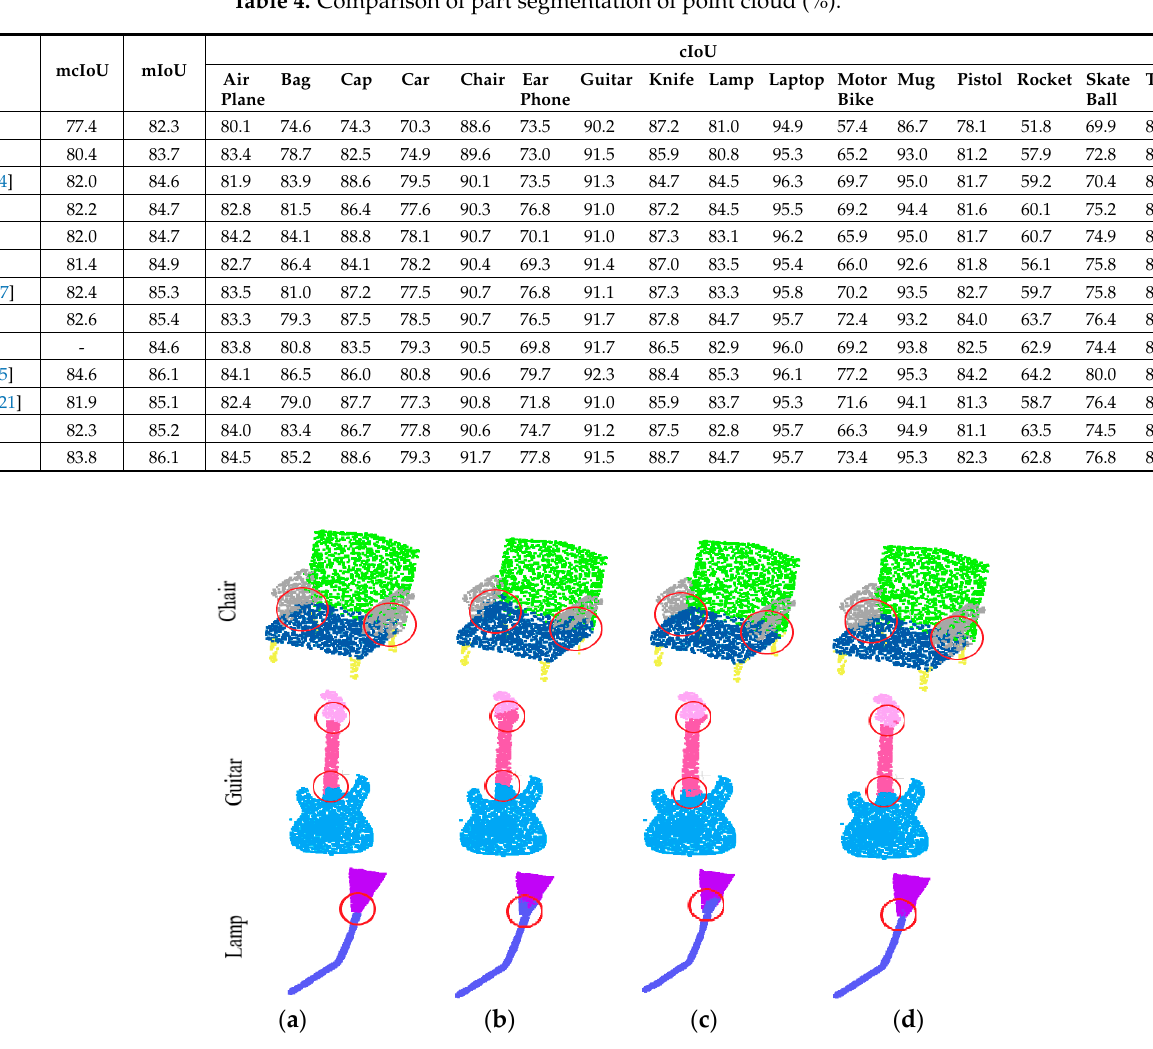
Table 4. Comparison of part segmentation of point cloud (%).